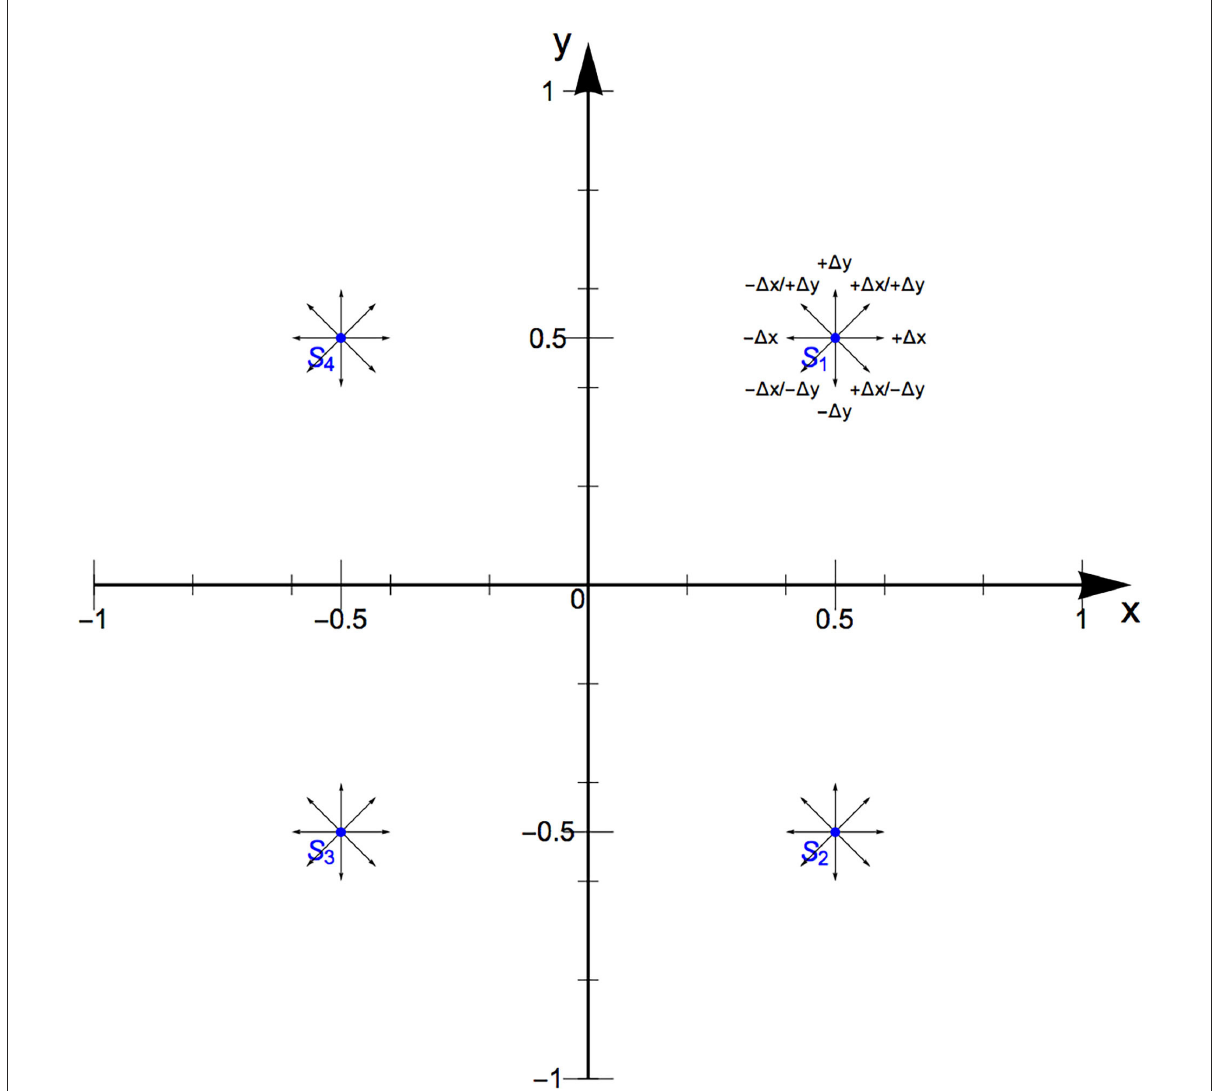
FIGURE2 The mapping space. It has two linear dimensions that are normalized from − 1 to 1. The maximum likelihood procedure (MLP) is carried out in 5 directions (small arrows) at 4 locations ( S I to S IV ) to quantify the perceptual resolution, hysteresis effects, and perceptual interferences. The standards lie in the center of each